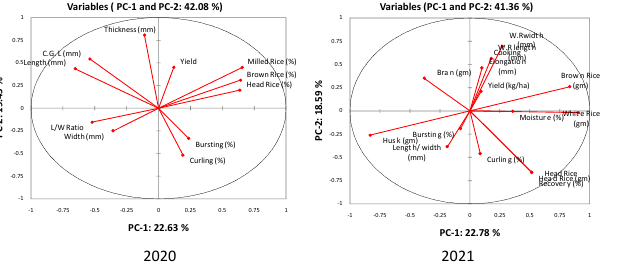
Figure 4. Traits variation on the basis of their major principal components under adaptability trials